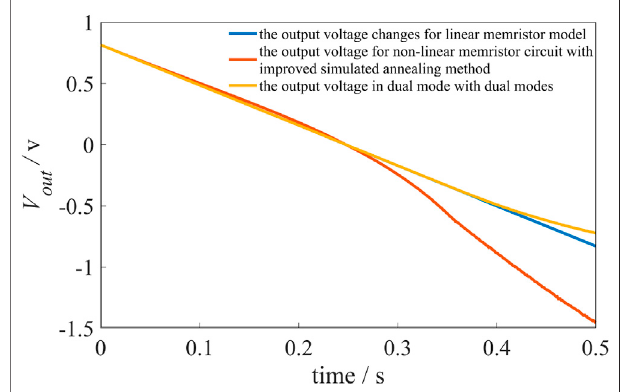
FIGURE 7 | The output voltage changes for linear and non-linear memristor models with and without using improved simulated annealing method.